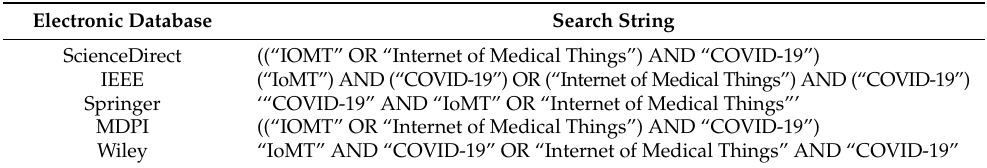
Table 1. Search string for different publication databases.